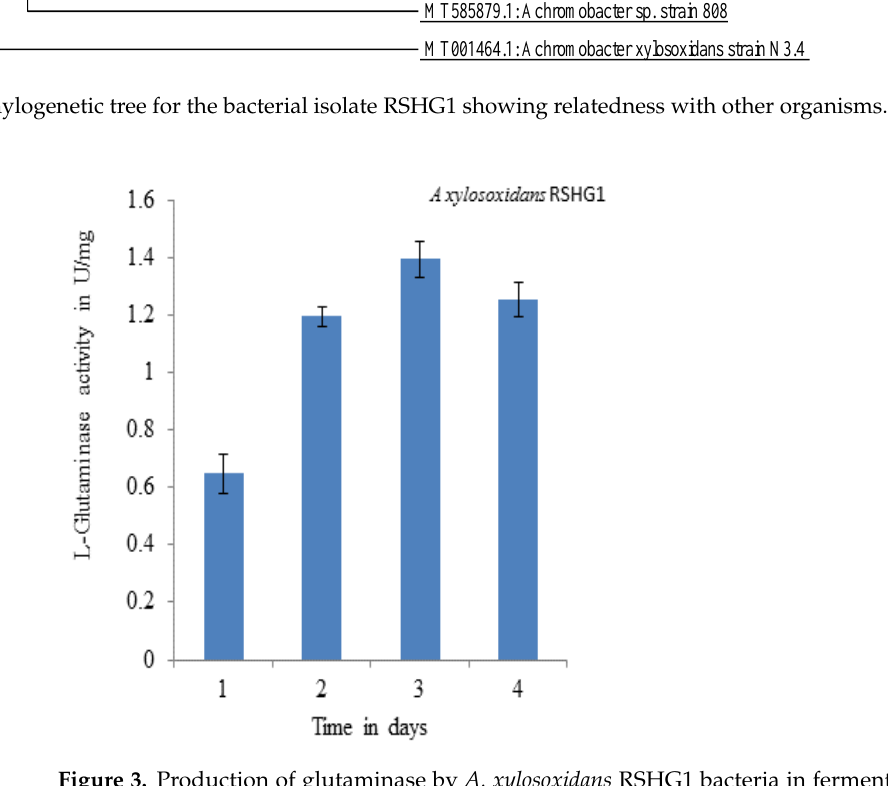
Figure 4. Effect of pH on glutaminase production by A. xylosoxidans RSHG1 on fermentation media at 30 °C.